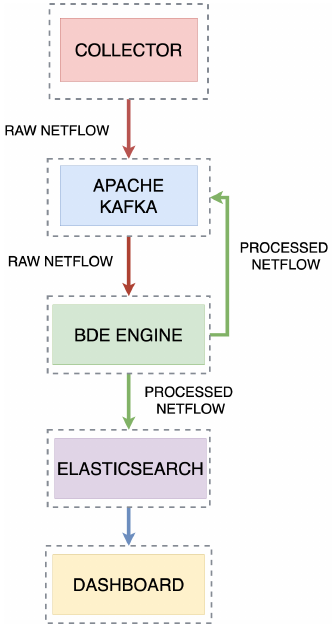
Figure 2. Architecture: Detection